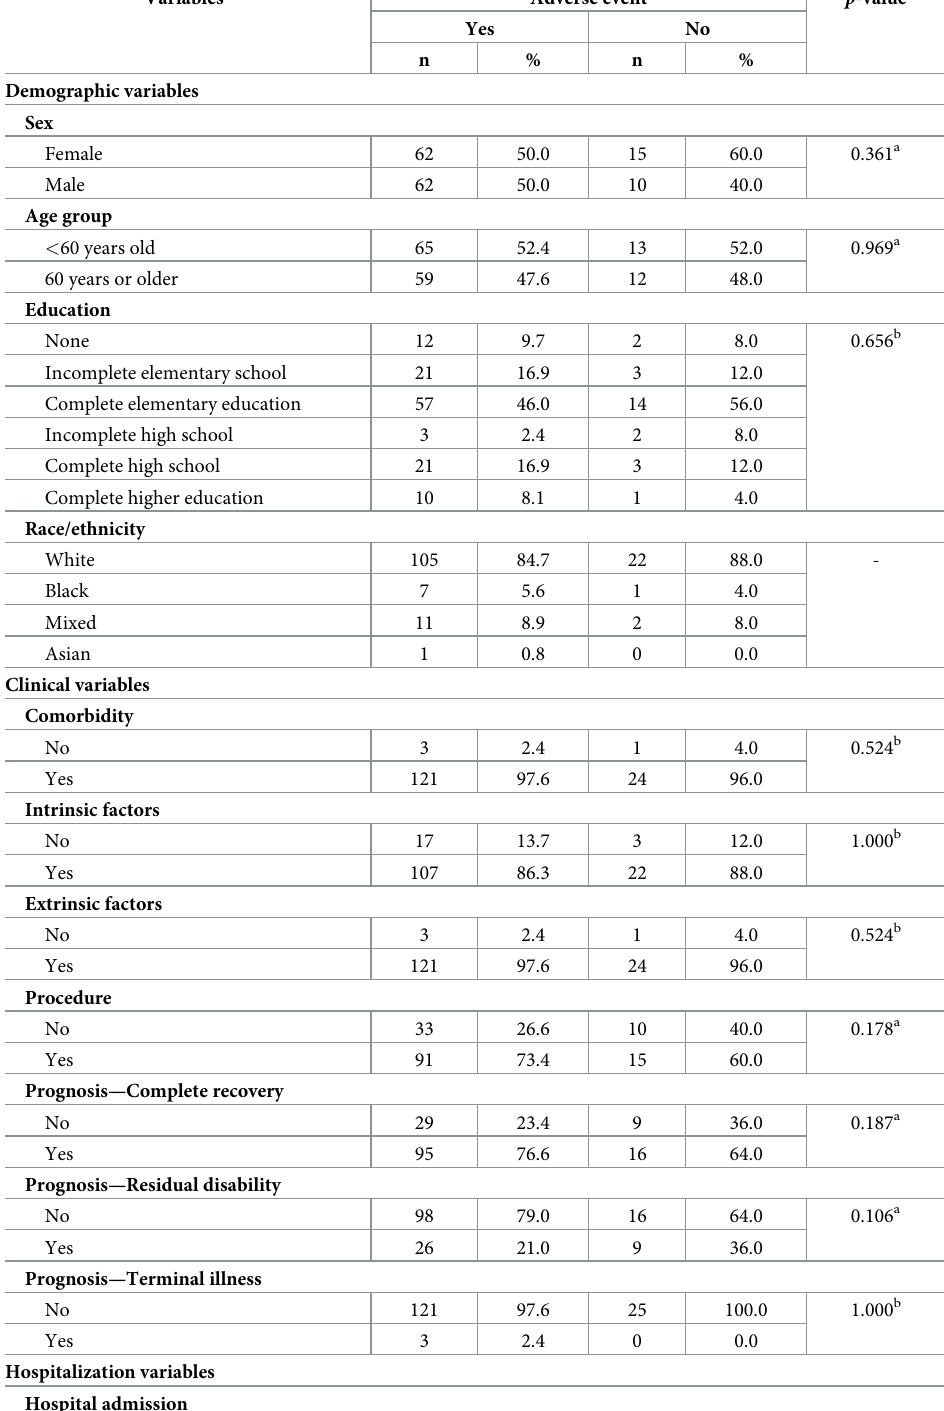
Table 1. Demographic, clinical, and hospitalization characteristics of the groups of patients with and without adverse events.